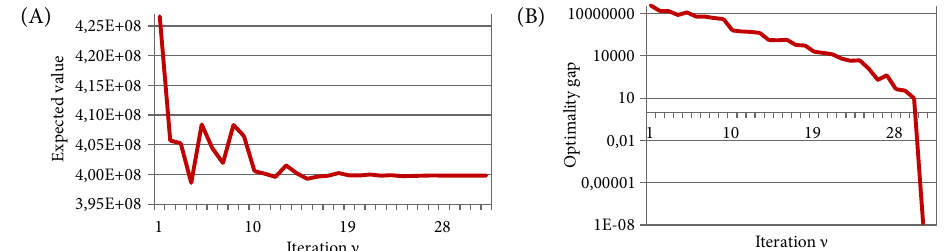
Fig. 3. Stochastic solution values during the